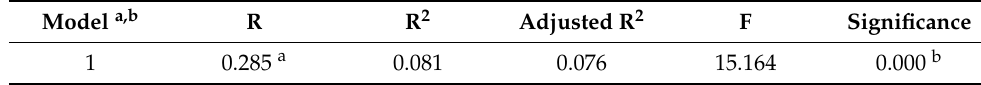
Table 14. Overall fitting degree of the model.